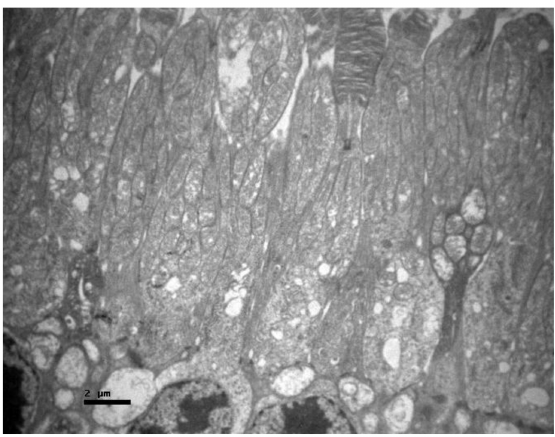
Figure 5. Group C. Photoreceptor layer with no ultrastructural pathological